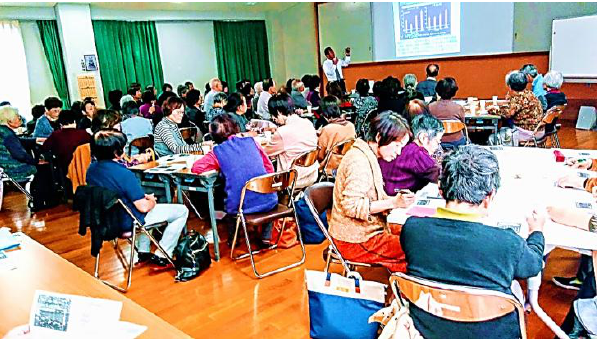
Figure 1: Supporter Training course for the prevention of dementia.